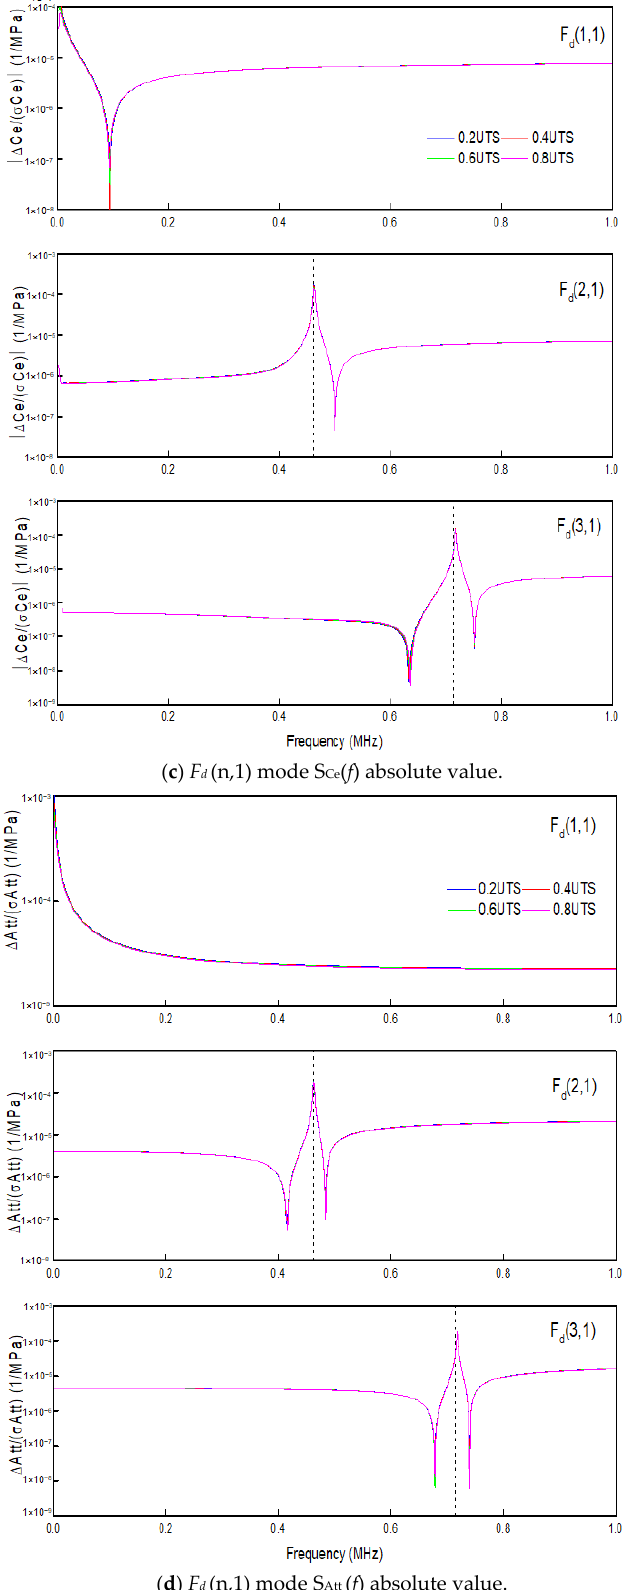
Figure 17. Acoustoelastic constant curves: ( a ) L d (0,m) mode S Ce ( f ) absolute value; ( b ) L d (0,m) mode S Att ( f ) absolute value; ( c ) F d (n,1) mode S Ce ( f ) absolute value; ( d ) F d (n,1) mode S Att ( f ) absolute